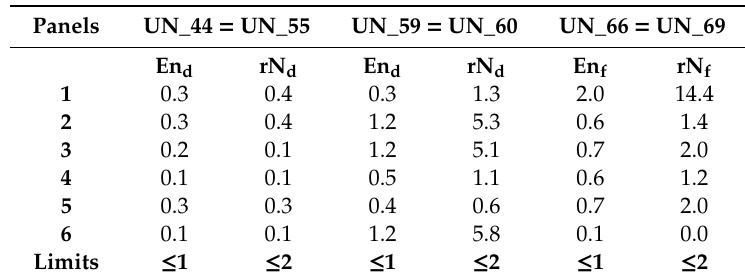
Table 1. Values of repeatability number (rN), normalized error (En) of each panel for the predominant defect (d) or fruity attribute (f) and suggested limits for these parameters, calculated on the three pairs of samples (UN_44 / UN_55, UN_59 / UN_60, UN_66 / UN_69) evaluated in the replicate analysis (blind